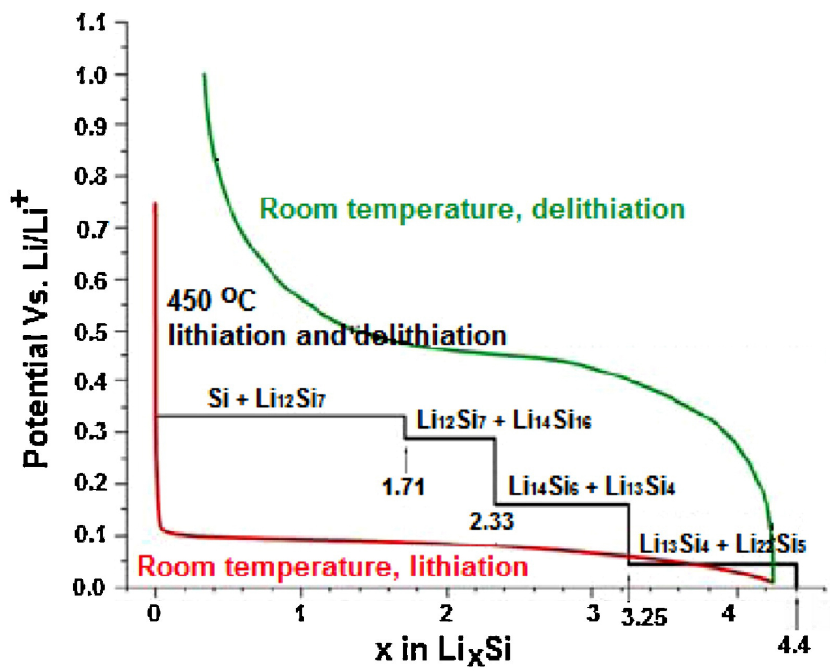
Figure 1. Si lithiation/delithiation curves at room temperature and 450 °C [69]. Reprinted with permission from Ref. [69]. Copyright 2012, Nano Today.